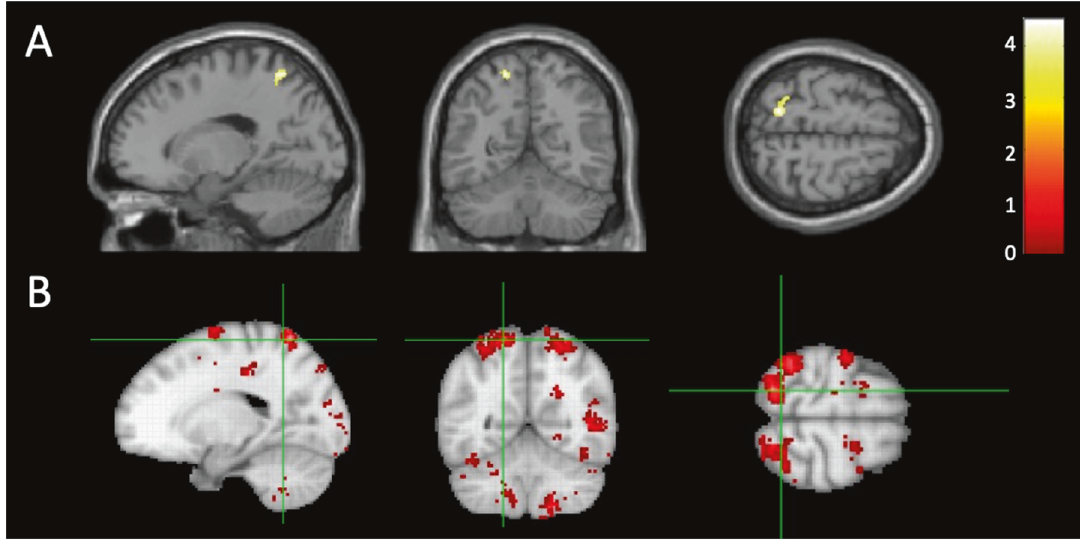
Fig. 2 Results of the multiple regression analysis between OXT mi and the regional gray matter volume (GMV). A Brain region showing negative correlations between the degree of OXT mi and GMV in the left SPL ( x = − 17, y = − 56, z = 65 [BA 7], T = 4.50, cluster size = 157 voxels) as determined by the multiple regression analysis. The statistical threshold for the contrasts was voxel-level P < 0.001 uncorrected for height and cluster-level P < 0.05 FDR -corrected for multiple comparisons. The color bar denotes the t -statistic range. B Brain activation